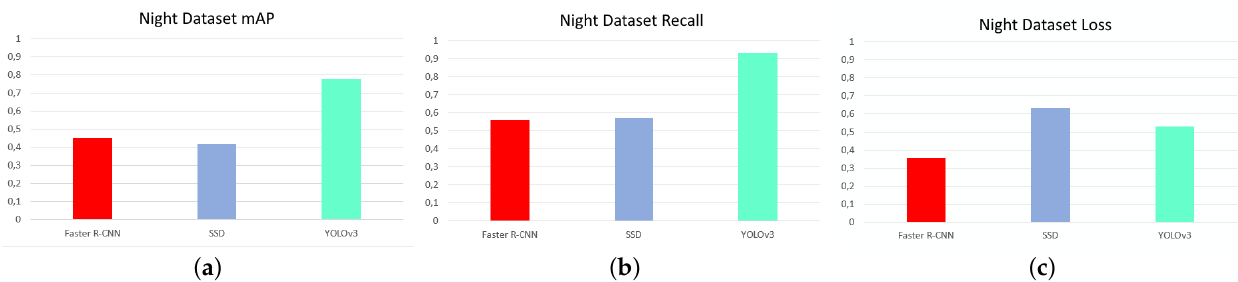
Figure 8. mAP, recall, and loss for networks with night dataset. ( a ) mAP, ( b ) recall, and ( c ) loss. Source: Authors.